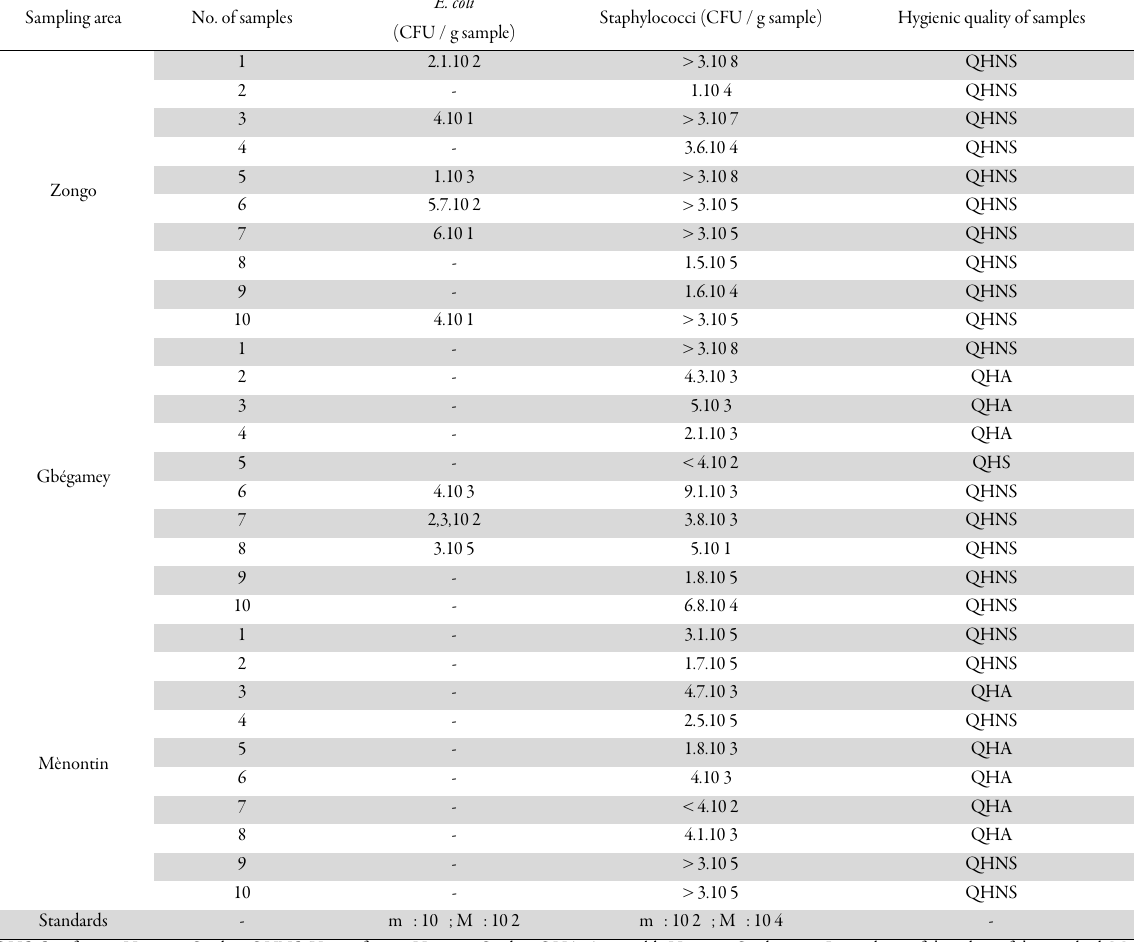
Table 1. Enumeration of E. coli and Staphylococci in grilled meat samples and the hygienic quality of these samples Sampling area No. of